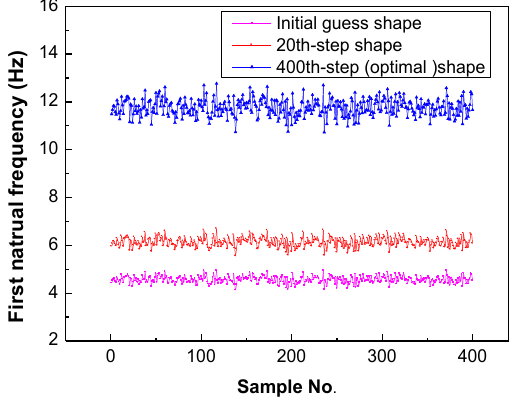
Figure 8. First natural frequency of Model 1.